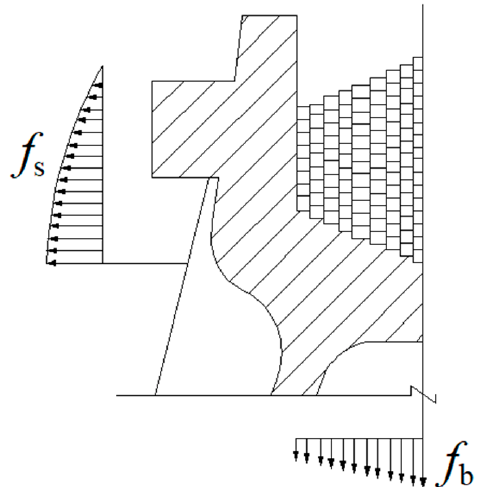
Figure 3. Schematic of force on cable-bearing trough.